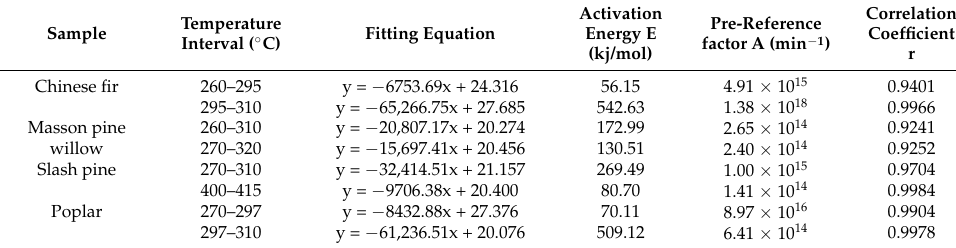
Table 4. Kinetic parameters in different temperature